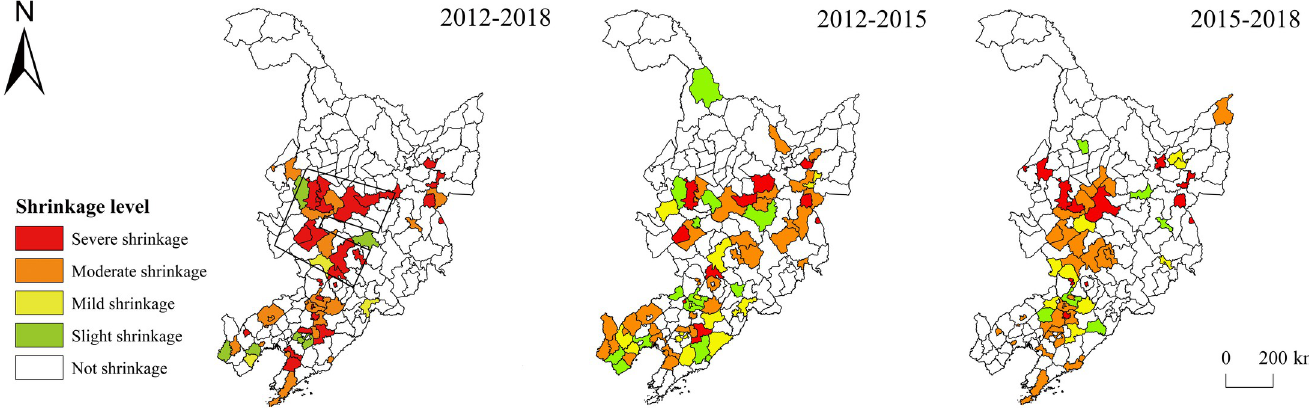
Fig 5. Spatial difference of space-related shrinkage of the three northeastern provinces. Note: The basic map came from a public map from the standard map service website of the Ministry of Natural Resources of China. The drawing approval number is GS (2016)1593.